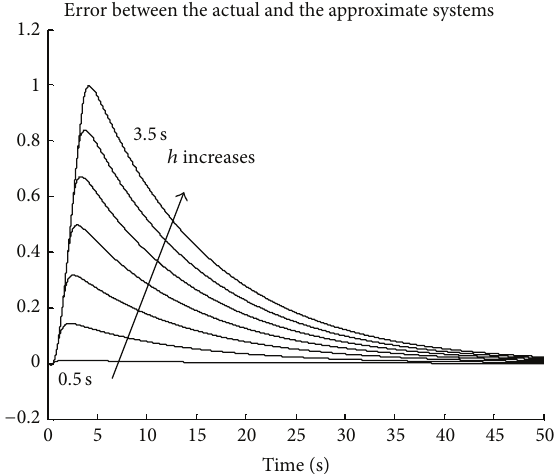
Figure 5: Effect of the variation of the sampling time, ℎ , in the error of the first state variable, 𝑥 1 (𝑡) .